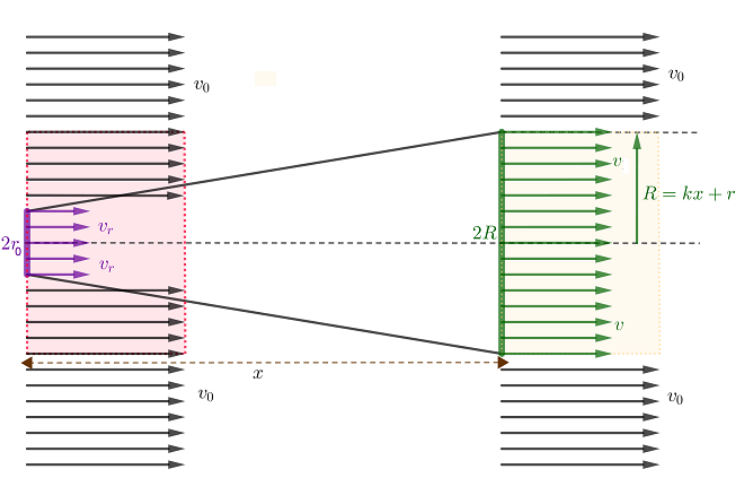
Figure 1. Illustration of the Jensen wake model.